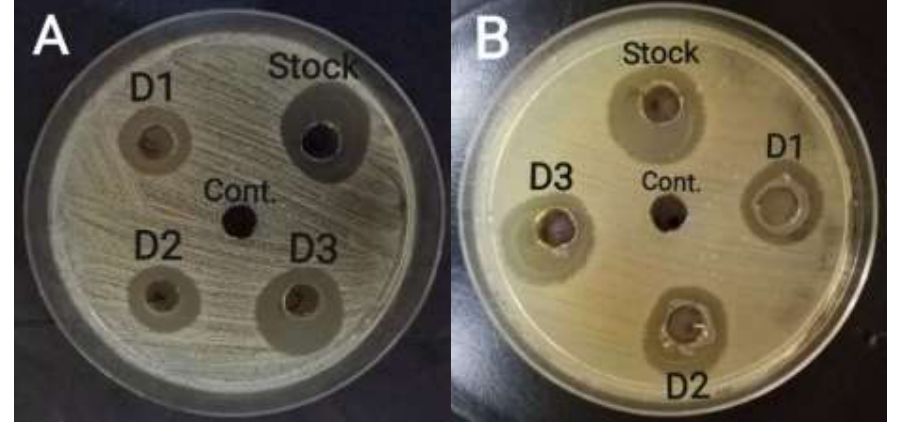
Figure 7: The inhibitory effect of AgNPs against bacterial isolates. (A) S.haemolyticus , (B) K.pneumoniae . D1= 12.5%, D2= 25%, D3= 50%, stock=100% concentrations, cont.